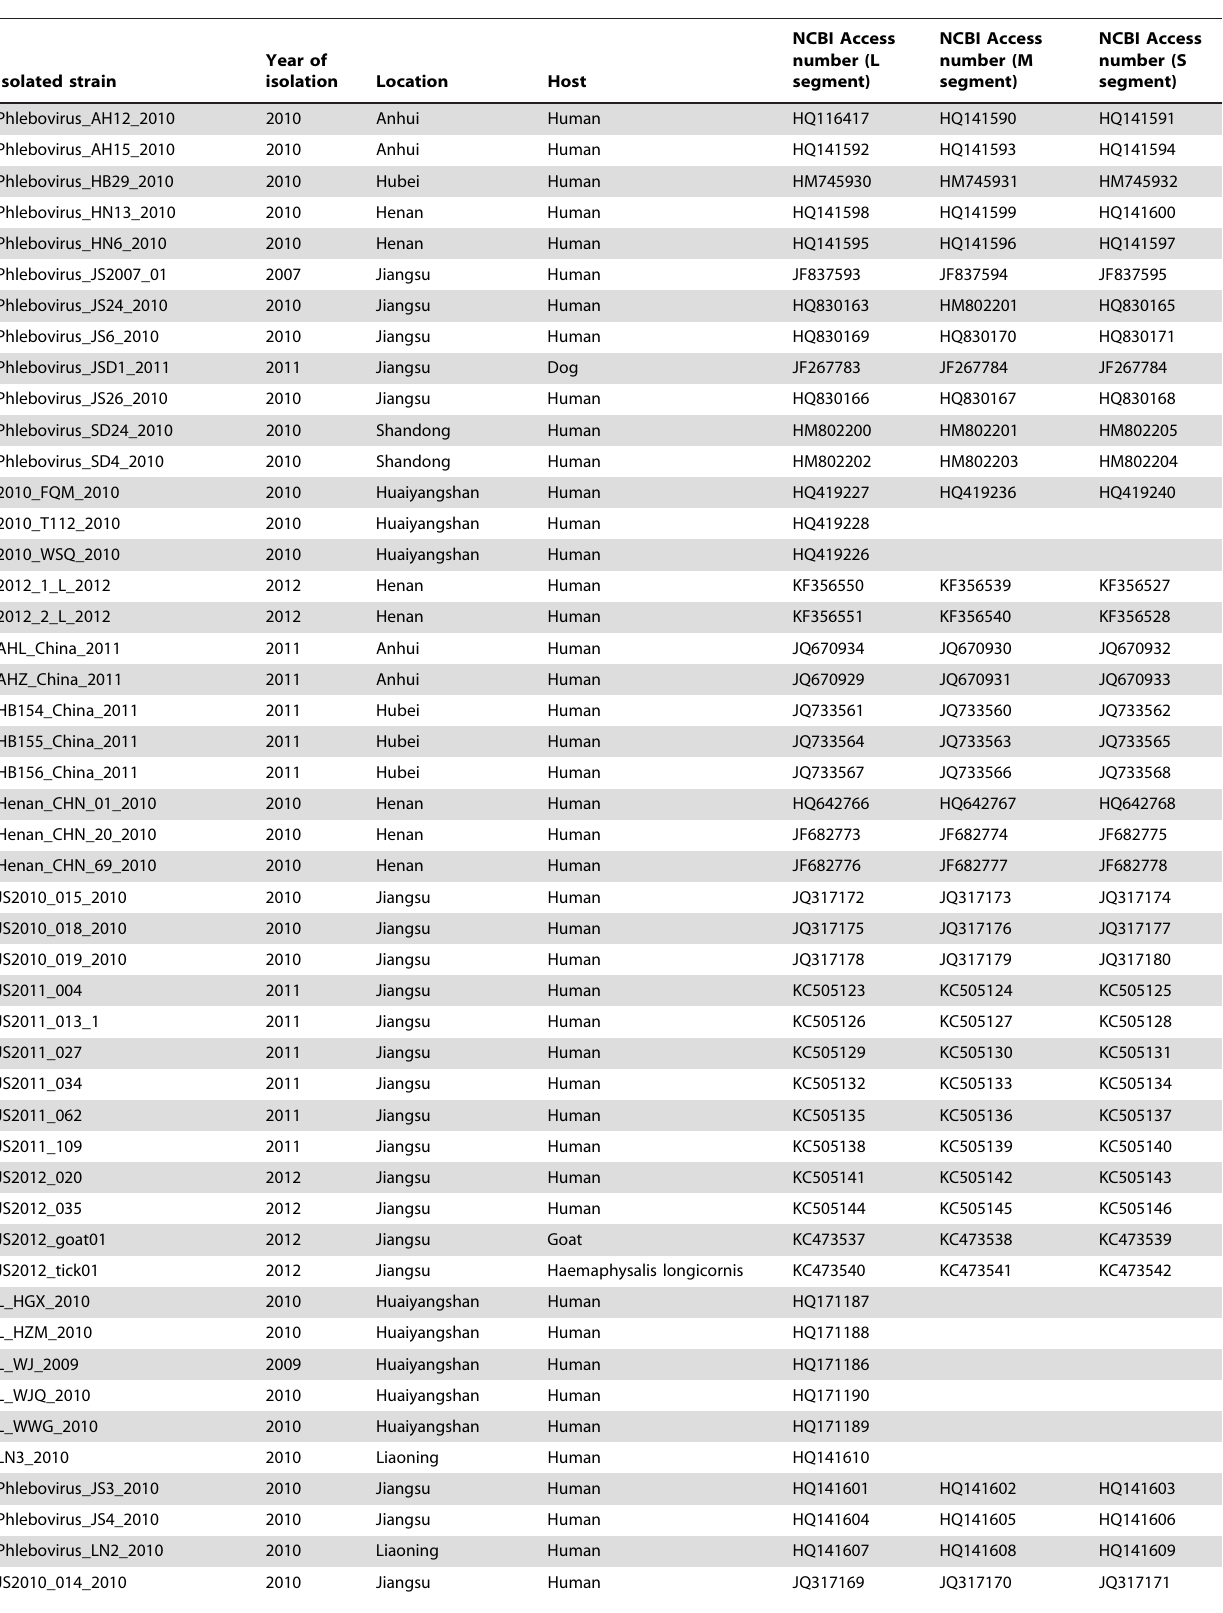
Table 1. Sequences of FTLSV with associated location of origin, collection dates, host and GenBank accession numbers.